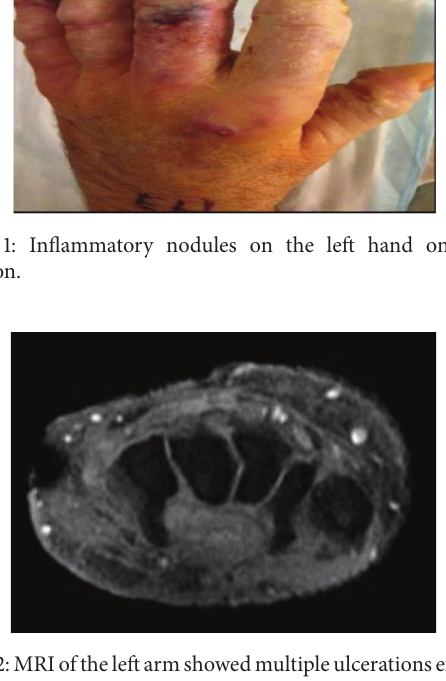
Table 1: Susceptibility testing result of M. marinum in our patient.